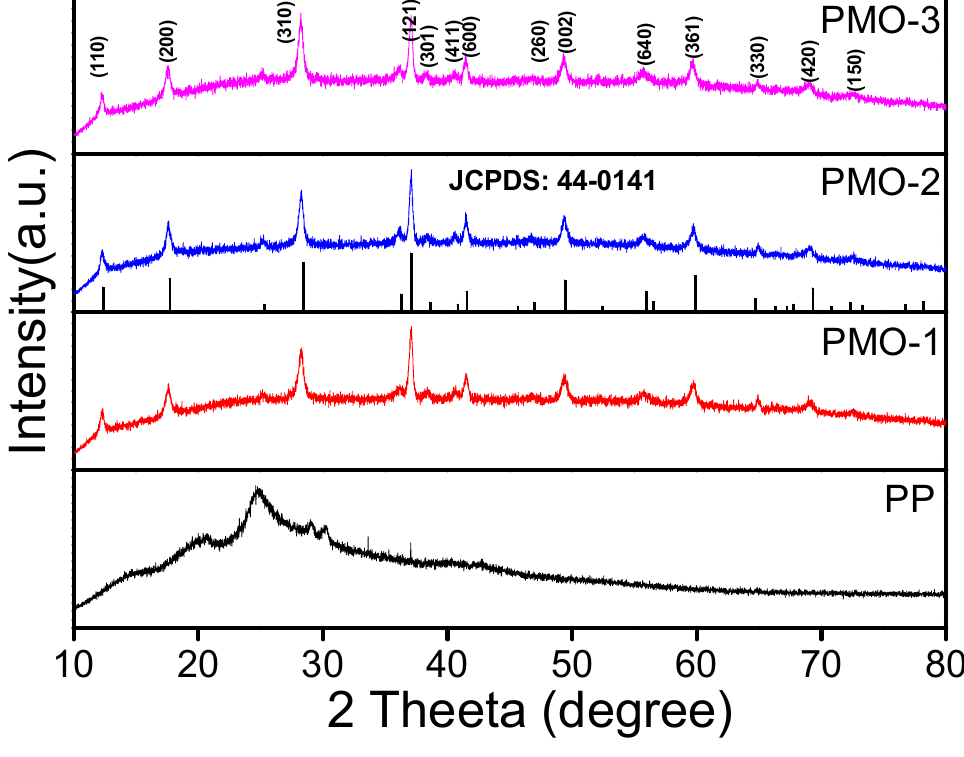
Figure 1. XRD patterns for PP, PMO-1, PMO-2, and PMO-3. Table 1. FWHM and crystalline size of the nanocomposites.